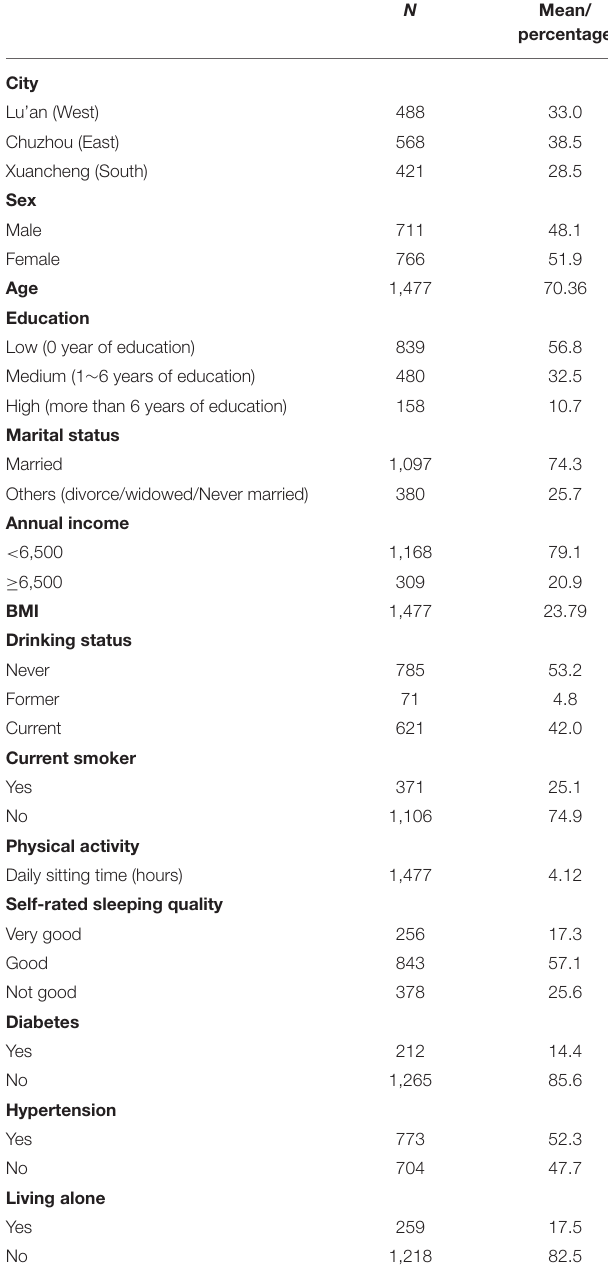
TABLE 1 | Basic characteristics of the